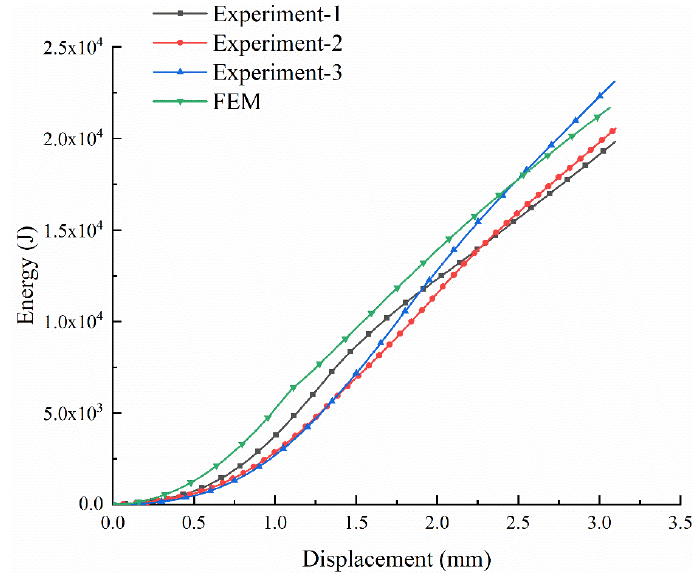
Figure 9. The energy-displacement curves of the experiment and FEM.